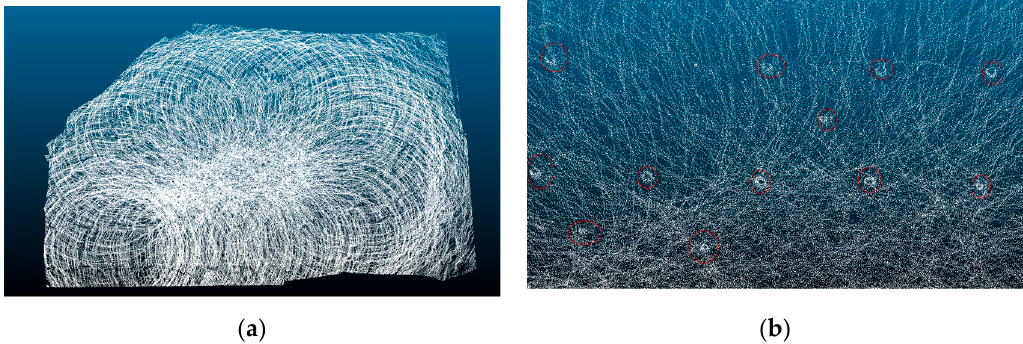
Figure 6. Overall and partial map of the ground point cloud. ( a ) Overall map of the ground point cloud; ( b ) partial enlargement of the ground point cloud, the removed ground point cloud contains the trunk portion, and the red circle is marked.